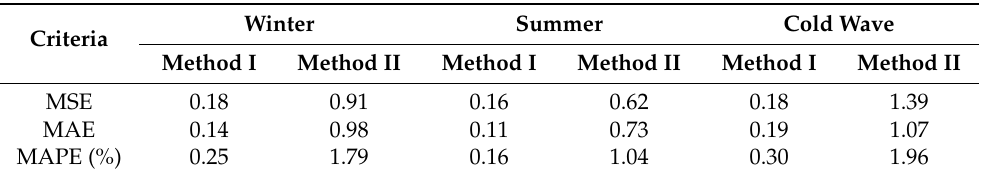
Table 4. Statistical indicators of Method I and II under a normal working state under different weather